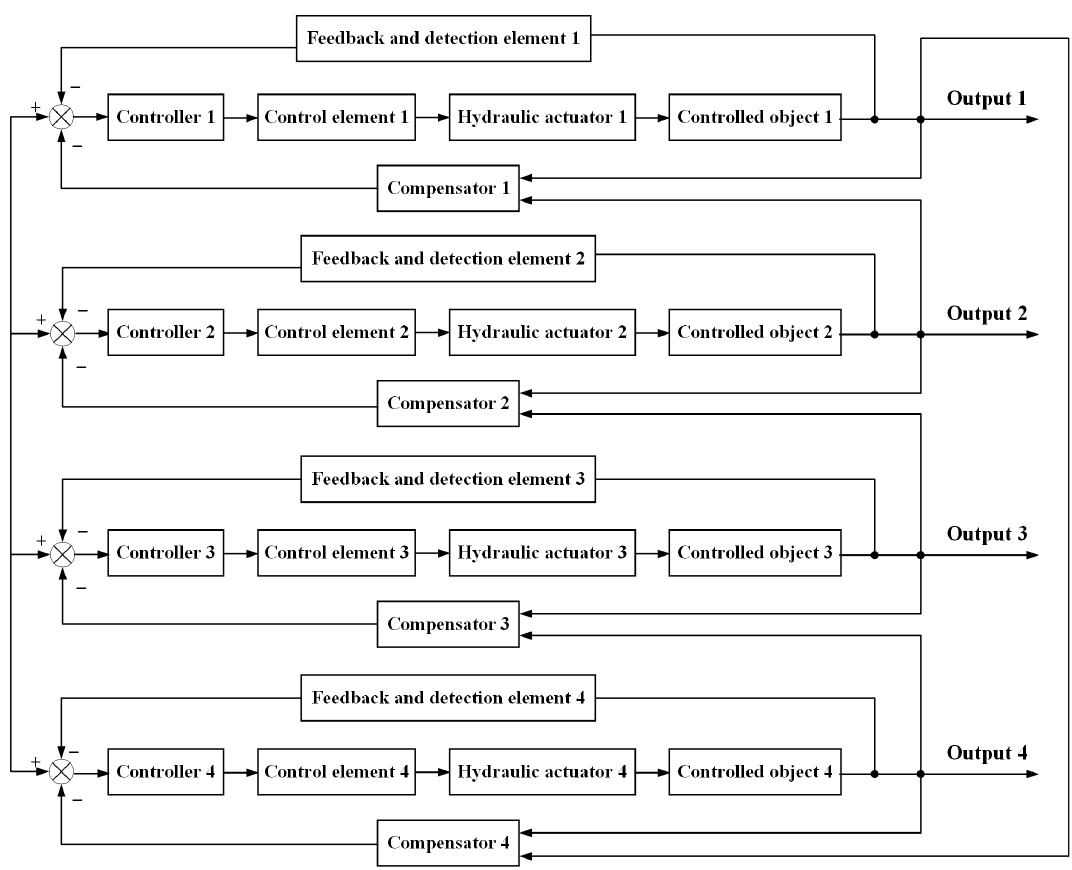
Figure 5. Adjacent cross-coupling control block diagram of the hydraulic synchronization control system.